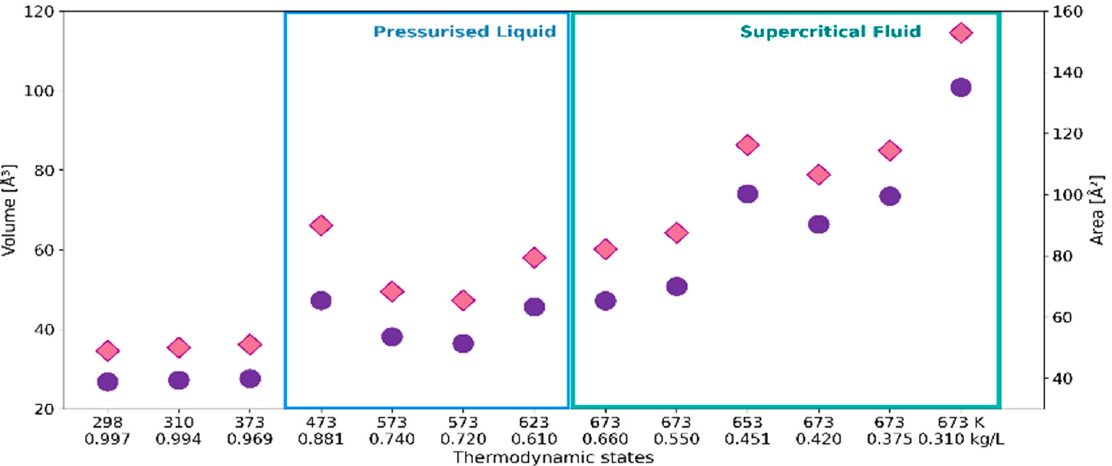
Figure 2. Volume V (circles, left axis) and surface area S tot (diamonds, right axis) of VP representing • OH aq at the thermodynamic states defined by temperature and density as in Table 1.